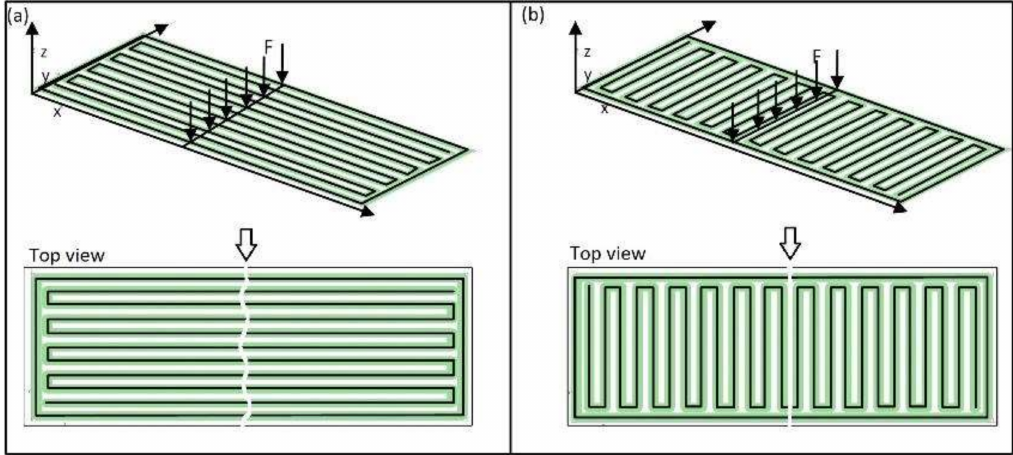
Figure 11. Parts manufactured with raster angle ( a ) low (0 ◦ ) and ( b ) high (90 ◦ ) with their loading conditions and failure modes as top